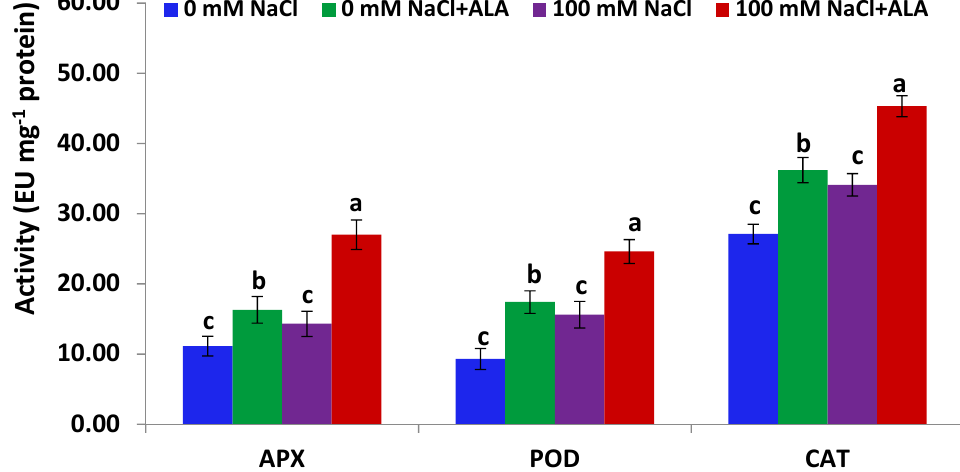
Figure 4. APX, POD and CAT activities in Carmen cultivar leaves under salt and/or ALA (7 ppm) effects. Values represent means ± SE ( n = 4). Different letters show significant difference among treatments ( p ≤ 0.05).